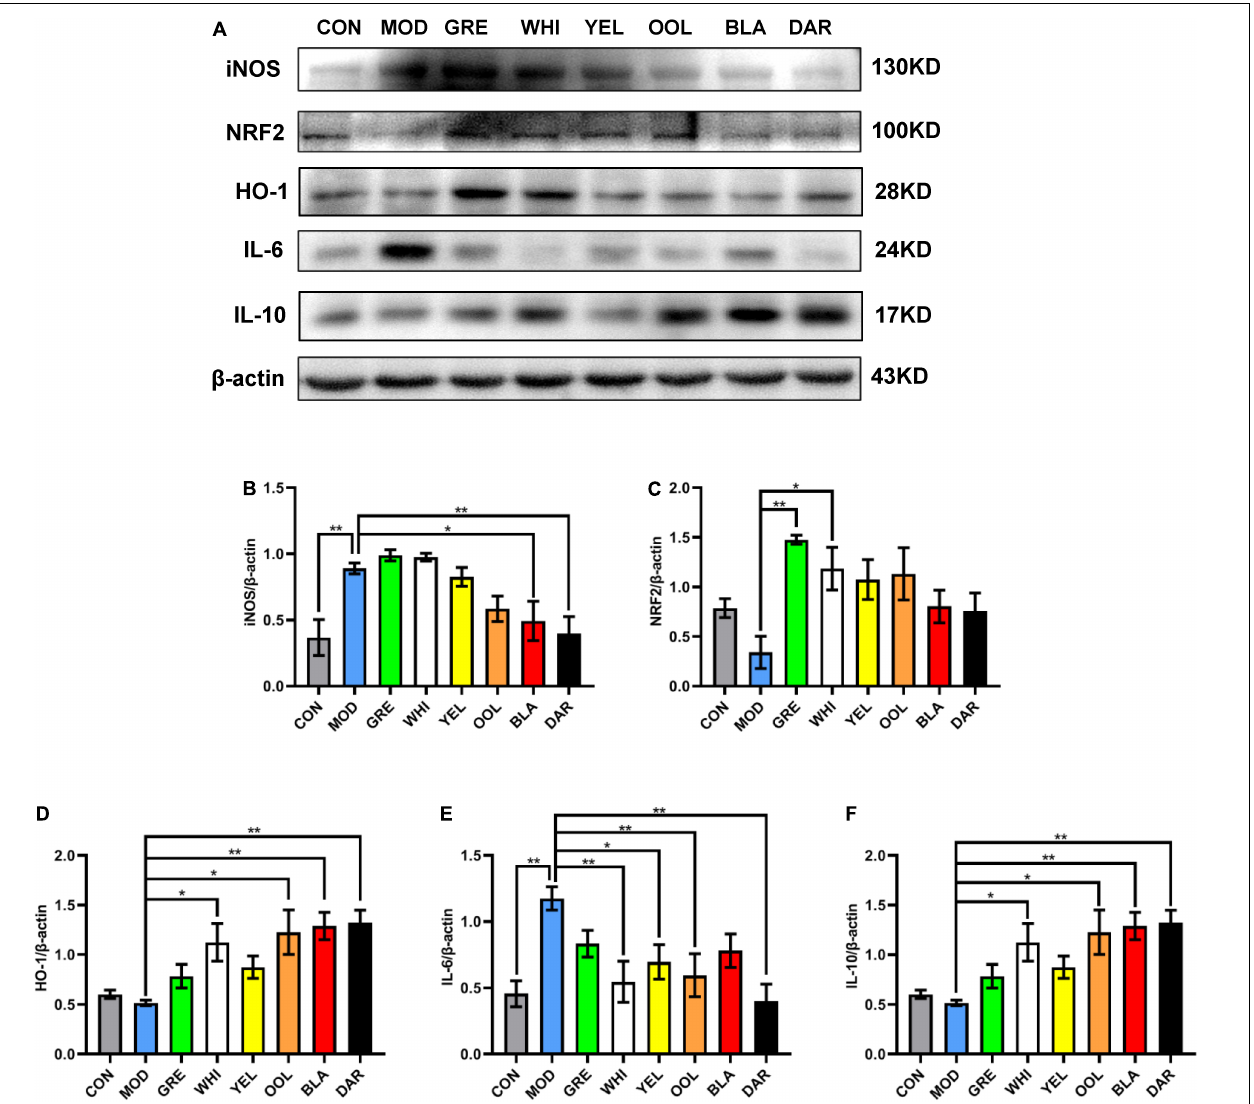
FIGURE 8 | Effects of WEATs on iNOS, NRF2, HO-1, IL-6, and IL-10 expression in the liver of mice. Representative immunoblots (A) of iNOS, NRF2, HO-1, IL-6, and IL-10 expression in the liver. Quantification of iNOS (B) , NRF2 (C) , HO-1 (D) , IL-6 (E), and IL-10 (F) expression by western blotting. Each value represents the mean ± SEM ( n = 10). * p < 0.05 vs. MOD; ** p < 0.01 vs. MOD.